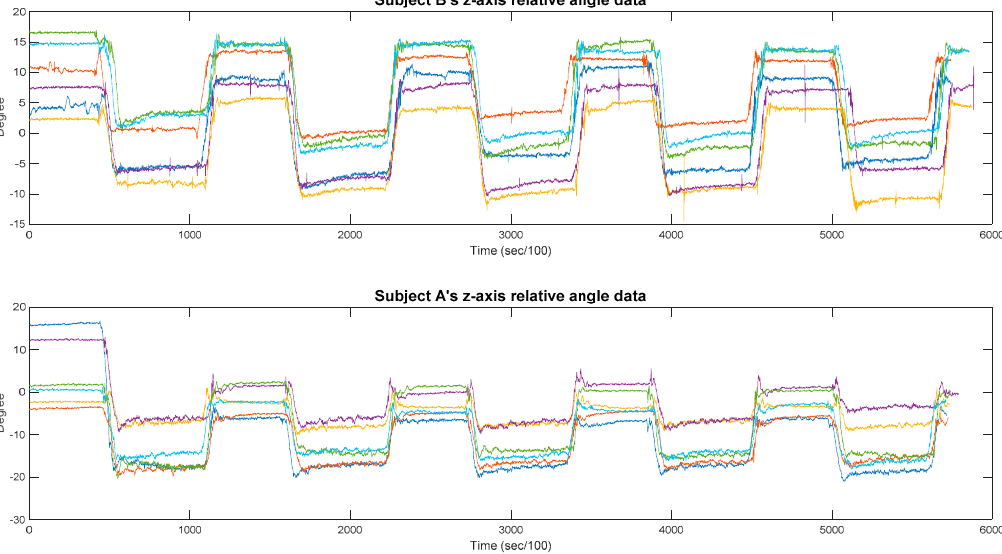
Figure A1. Variation of Ex. 2 (cid:48) s original motion angles in z-axis for subjects A and B. The averages of standard deviation (feature z11) for subjects A and B are 50 and 0.9, respectively, and the absolute standard deviation (feature z12) is 69 and 0.9. The z11 and z12 of training data are 0.9 and 0.9, respectively. Subject A adjusted the motion postures, later on, to resubmit the correct measurement data for improving the analysis.